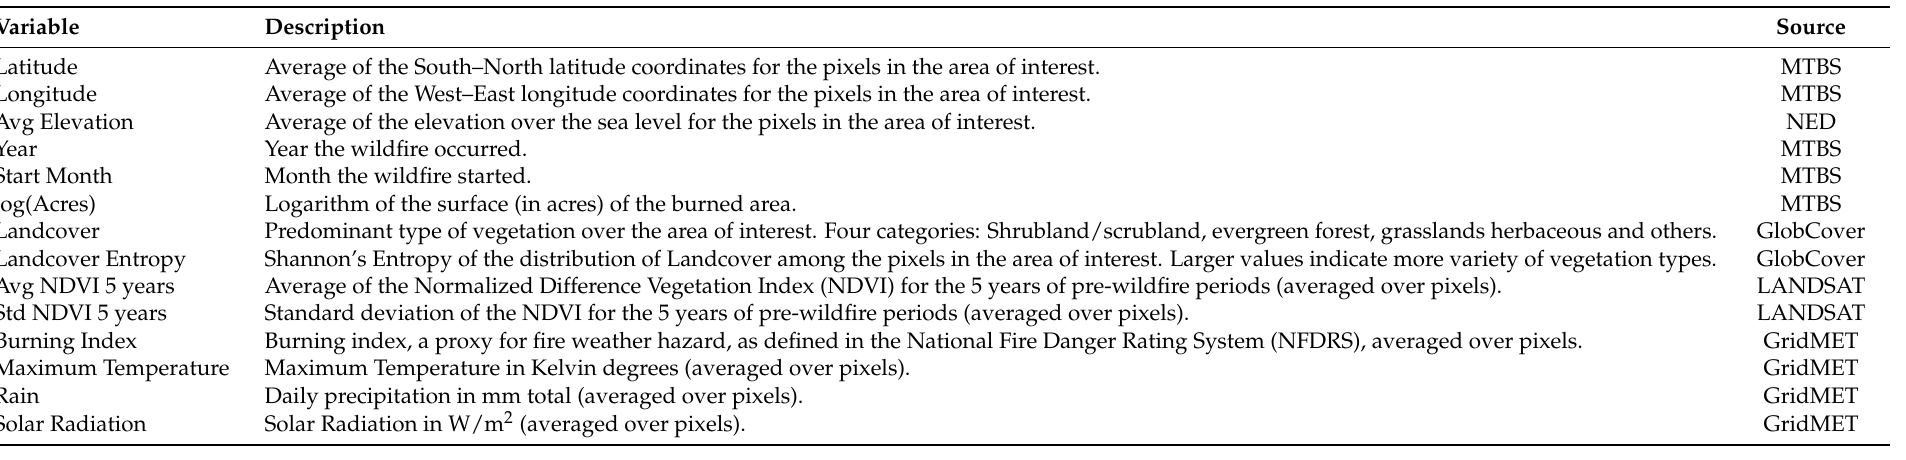
Table 1. Summary of the variables used in this study as covariates for the function-on-scalar